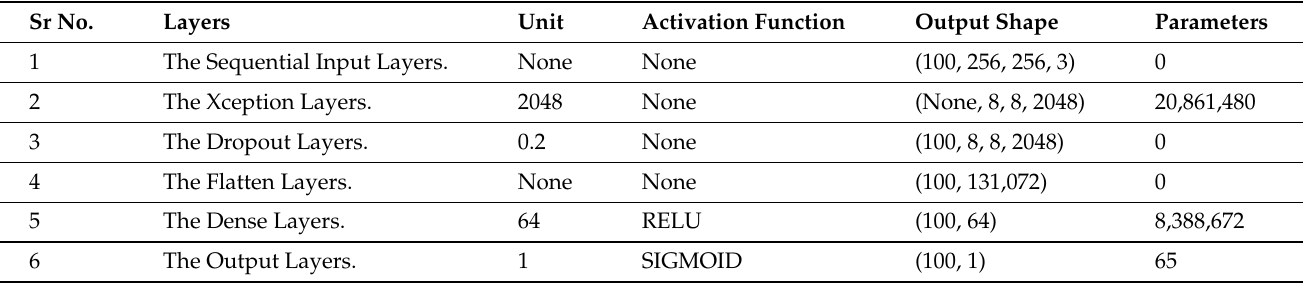
Table 2. The Xception model configuration parameters and layer architectural analysis.